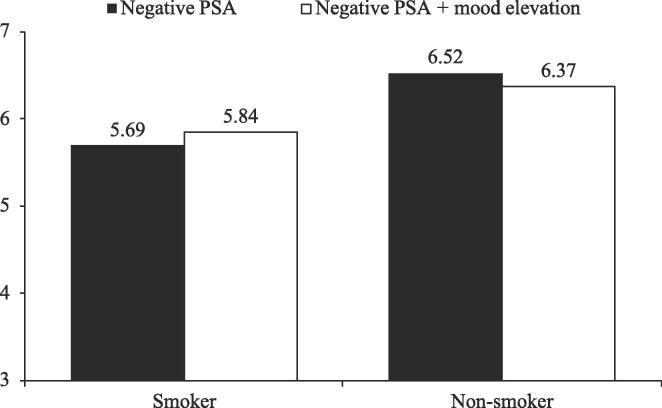
Message acceptance, Study 2.